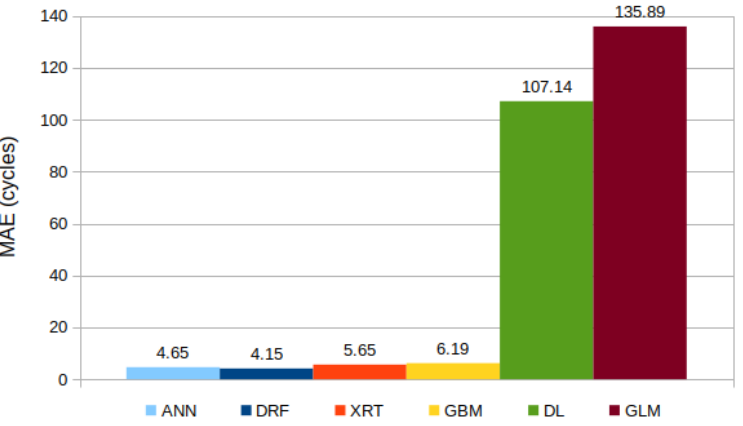
Figure 2. Results for mean absolute error (MAE) from different ML algorithms obtained via H 2 O AutoML.